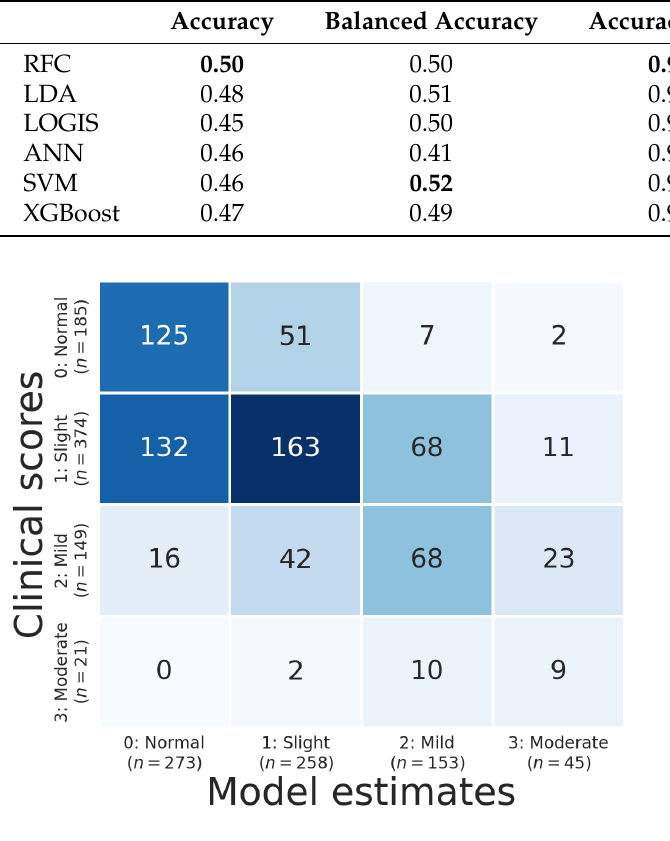
Figure 8. Confusion matrix showing the results from the 10-fold cross-validation based on ratings given by the original examiners at the clinical sites where the assessments were performed. Note that 15 videos were later re-rated by a senior neurologist, which changed the ratings of six videos (see Table 5). Table 5. Fifteen videos were sent to a senior neurologist for re-rating: Five videos for which the model estimation disagreed with the original examiner’s rating by 2, and ten videos for which the residual was 1 or 0 points. Each column shows the three different ratings (original examiner, model and expert) for a video, with color shading indicating the level of absolute residual (red = 2, yellow = 1, green =